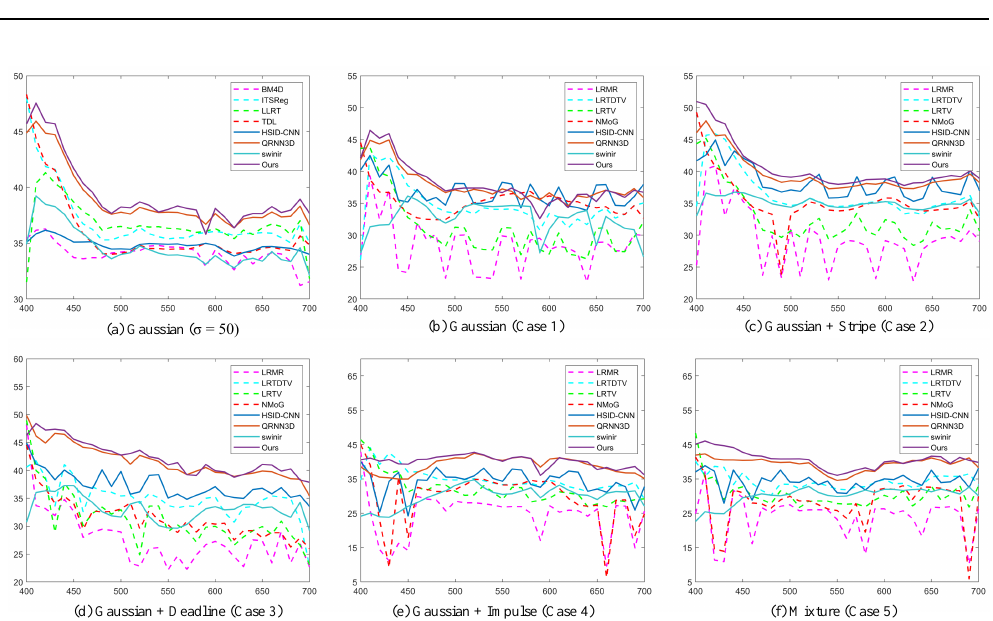
Figure 6. PSNR values of each band for the synthetic experiments. Complex Noise Denoising on CAVE : In addition to testing on ICVL, we also perform threefold cross validation on the CAVE dataset in the mixture noise case. Since the CAVE dataset is small, which is prone to cause overfitting, we employ a small amount of samples from the CAVE dataset to fine-tune the model trained on the ICVL dataset instead of training from scratch. All the competing DL-based approaches are trained in the same way for fair comparison. The experimental results are shown in Table 4, from which we can observe that our proposed TRQ3DNet obtains the best denoising performance compared with other